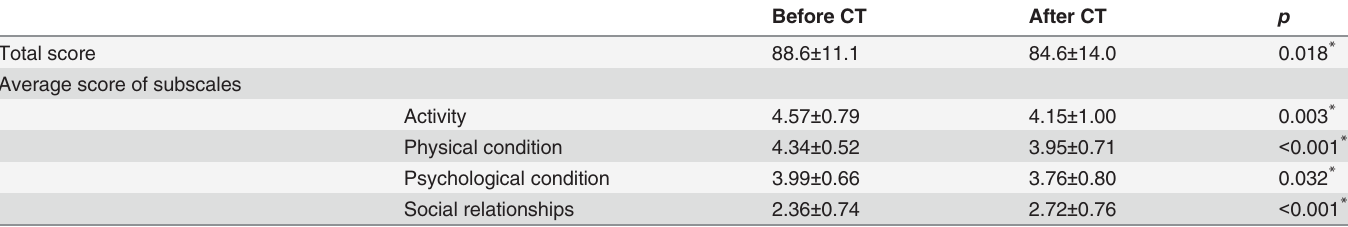
Table 3. Comparison of the QOL-ACD total score and mean score for each subscale before and after 1 course of outpatient chemotherapy.